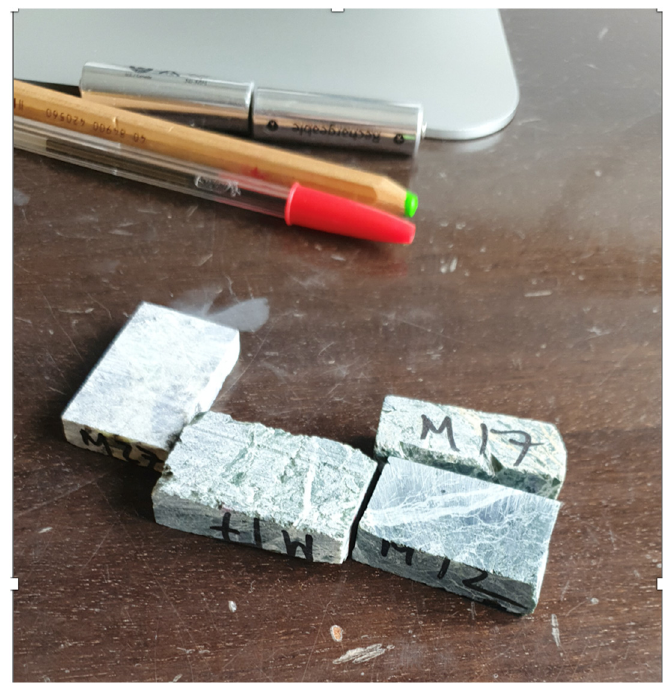
Figure 3. Slabs of commercial serpentinite used in our experiments. To characterise the stones, we used inductively coupled plasma mass spectrometry (ICP ‐ MS), laser ablation, petrographic microscopes, scanning electron microscopy with